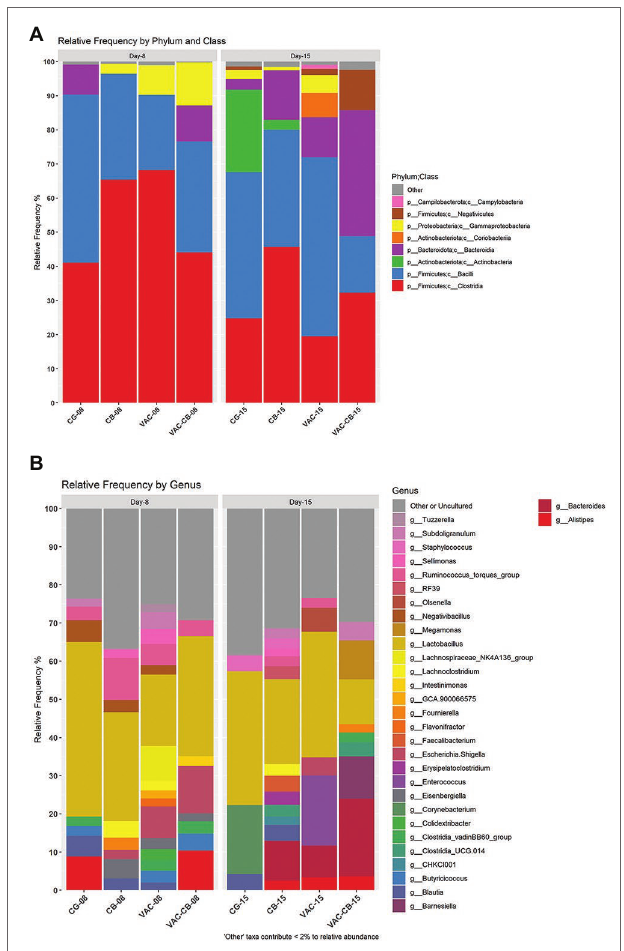
FIGURE 5 | Relative abundance of intestine microbiome taxa of various pretreatment groups at 8 and 15 days old. The relative abundance of microbial families was analyzed for the different experimental groups at two classification levels, class (A) and genus (B) , and visualized by stacked bar plots. The analysis was performed using microbiome package and ggplot2 package in R version 4.1.0. At the class classification level, the taxa with an overall abundance of less than 1% were summed into “other.” At the genus classification level, the overall abundance was less than 2% and “uncultured” is classified as “other or